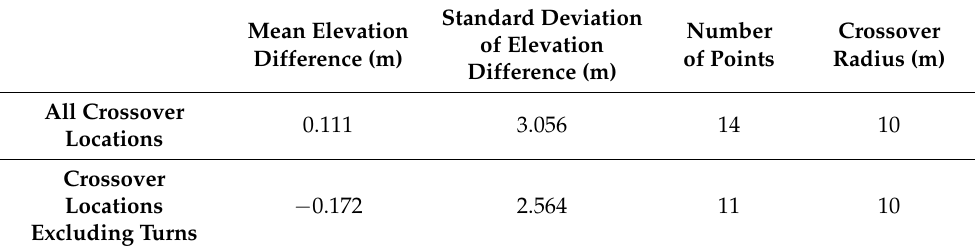
Table 4. Crossover analysis for Flight 2, 13 August 2019, Negribreen ICESat-2 Validation Cam- paign 2019. Estimates are given when using all crossover locations (seen in Figure 8) and for locations only along relatively straight flight segments, i.e., where the helicopter was not performing column of the